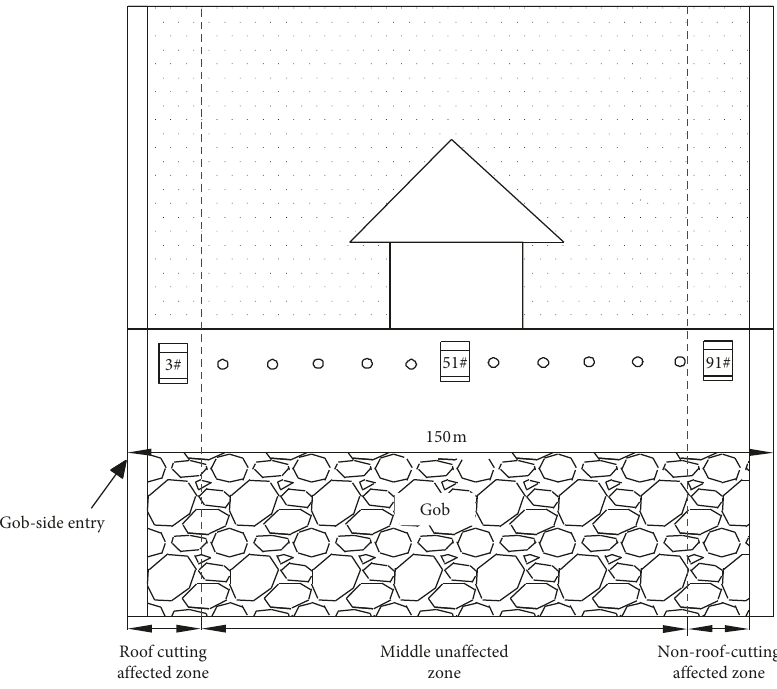
Figure 15: Monitoring points of support stress.